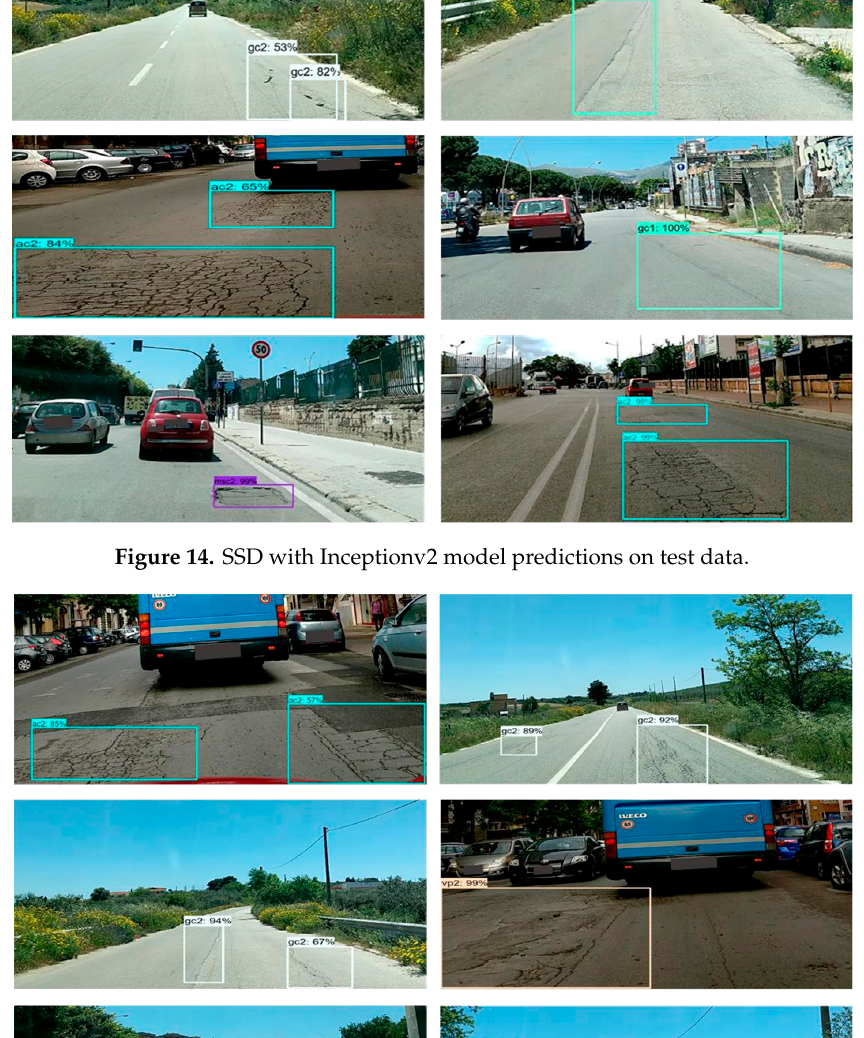
Figure 13. Faster R-CNN with inceptionv2 model predictions on test data.